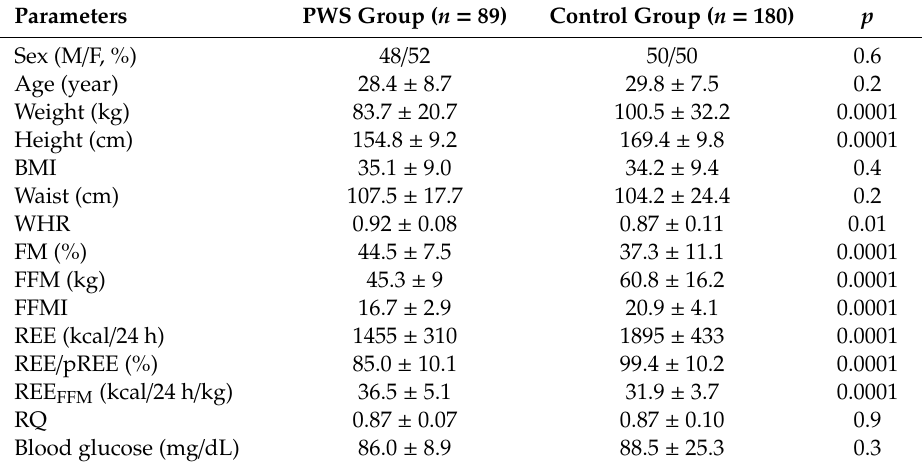
Table 1. Summary of anthropometric, metabolic, and biochemical parameters in patients with Prader-Willi syndrome (PWS) and control subjects. Significance was calculated by Mann-Whitney and chi-square